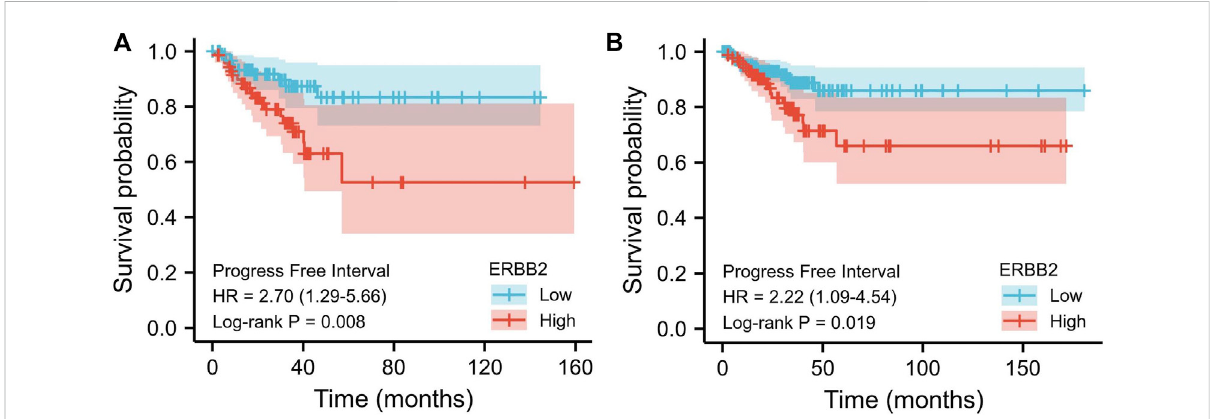
FIGURE 3 Kaplan-Meier curves of progression-free interval comparing the high and low expression of ERBB2 in thyroid cancer patients. (A) In stage III/IV patients, the progression-free interval of the high ERBB2 expression group was poorer than that of the low expression group ( p = 0.008). (B) In patients aged > 45 years, the progression-free survival of the high ERBB2 expression group was poorer than that of the low expression group ( p =